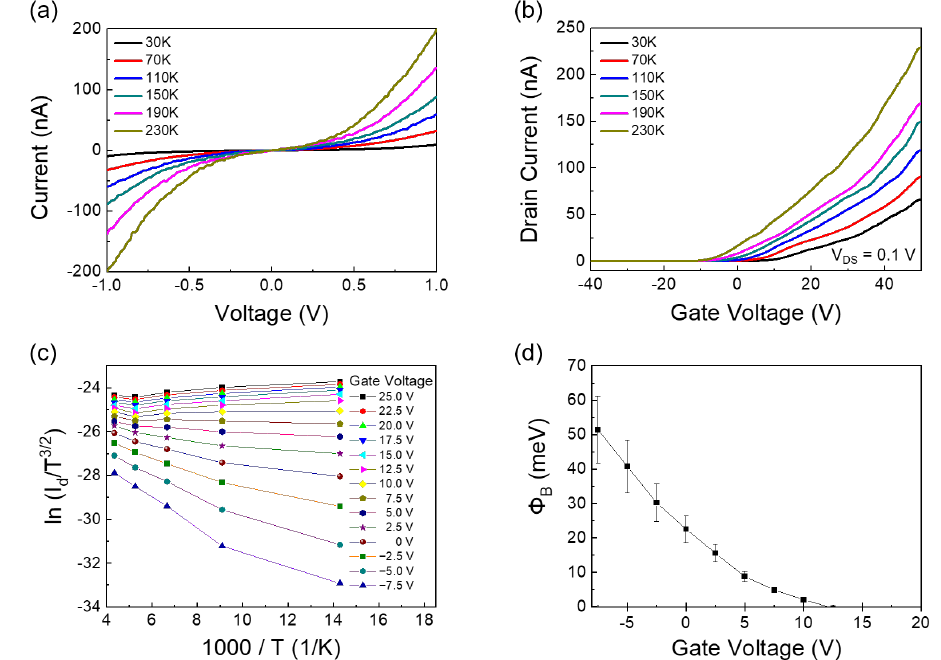
Figure 6. Temperature-dependent electrical transport of the MoS 2 FET with graphene electrode. ( a ) Current voltage characteristics and ( b ) I DS –V g transfer characteristics from 30 K to 230 K, for source-drain bias voltage of 0.1 V. ( c ) Linear fit of the Arrhenius plot, ln V g . ( d ) The Schottky barrier of MoS 2 FET with graphene electrode depends on the gate voltage.